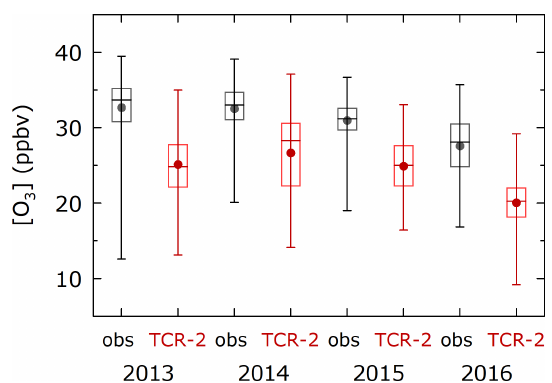
Figure 9. Repeated underestimations of O 3 mixing ratios ranges by TCR-2 relative to observed values in the Arctic region (>70 ◦ N). Boxes and horizontal bars indicate 75%, 50% (median), and 25%, and whiskers indicate 90% and 10%. Circles are averages.